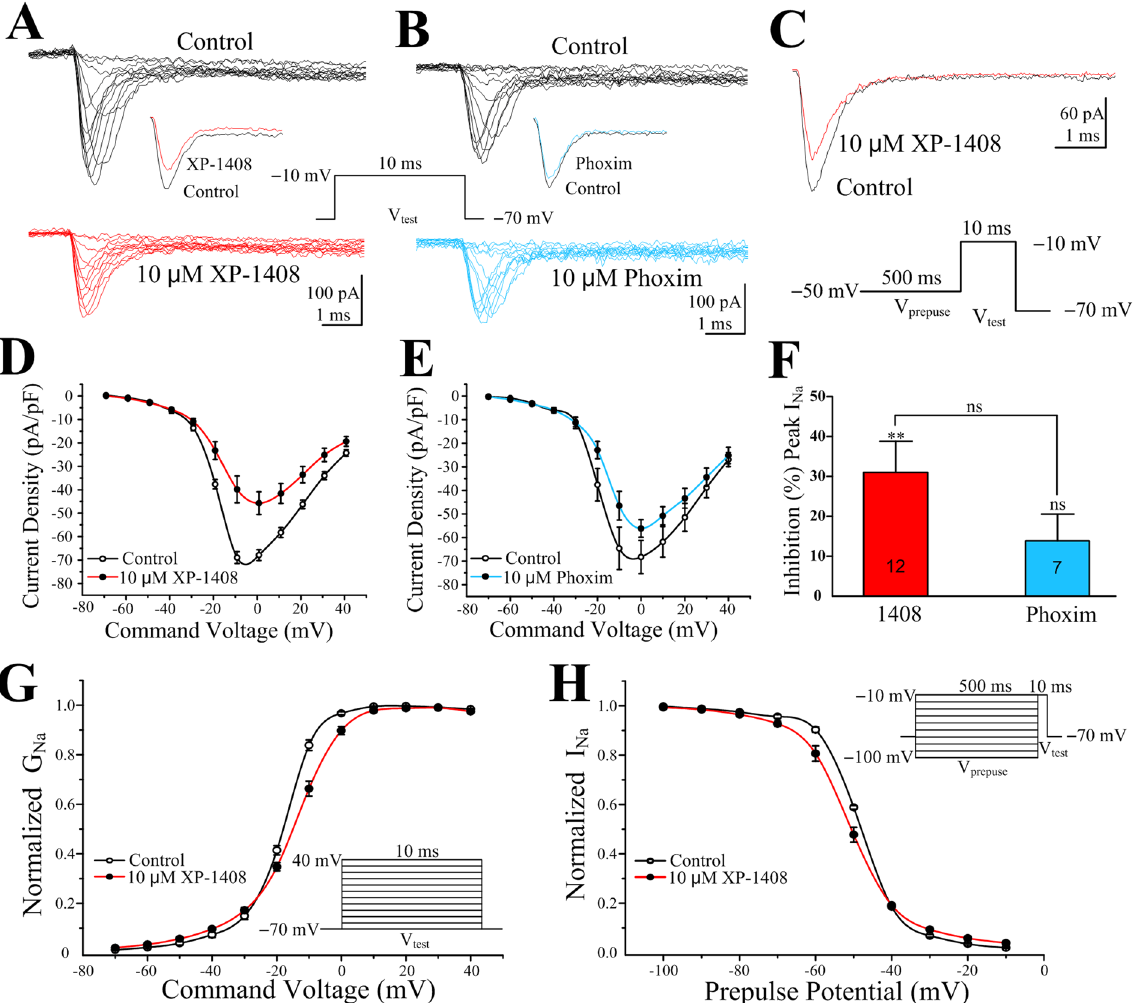
Figure 7. Effects of XP-1408 on whole-cell Na V channel currents in Drosophila PNs. ( A ) Typical families of I Na recorded in control conditions and 10 min after the application of 10 μ M of XP-1408. Inset is the high time resolution of I Na obtained at − 10 mV. ( B ) Typical families of I Na recorded in control conditions and 10 min after the application of 10 μ M of phoxim. Inset is the high time resolution of I Na obtained at − 10 mV. ( C ) Representative superimposed inactivation traces of I Na obtained at prepulse potential of − 10 mV in control conditions, and 10 min after the application of 10 μ M of XP-1408 (upperpanel). Pulse protocol is shown in the bottom panel. ( D ) The effects of 10 μ M of XP-1408 on the I-V curves of I Na . ( E ) The effects of 10 μ M of phoxim on the I-V curves of I Na . ( F ) Percentage inhibition of I Na 10 min after XP-1408 (10 μ M) and phoxim (10 μ M) application, normalized to control values (100%). ** P < 0.01 vs. control (I Na ). ns, not significant, P > 0.05. Bar represent means ± SEM from indicated number of neurons. ( G ) The effects of 10 μ M of XP-1408 on the steady- state activation curve of I Na . All data are expressed as the mean ± SEM of 12 cells. ( H ) The effects of 10 μ M of XP-1408 on the steady-state inactivation curve of I Na . All data are expressed as the mean ± SEM of 12